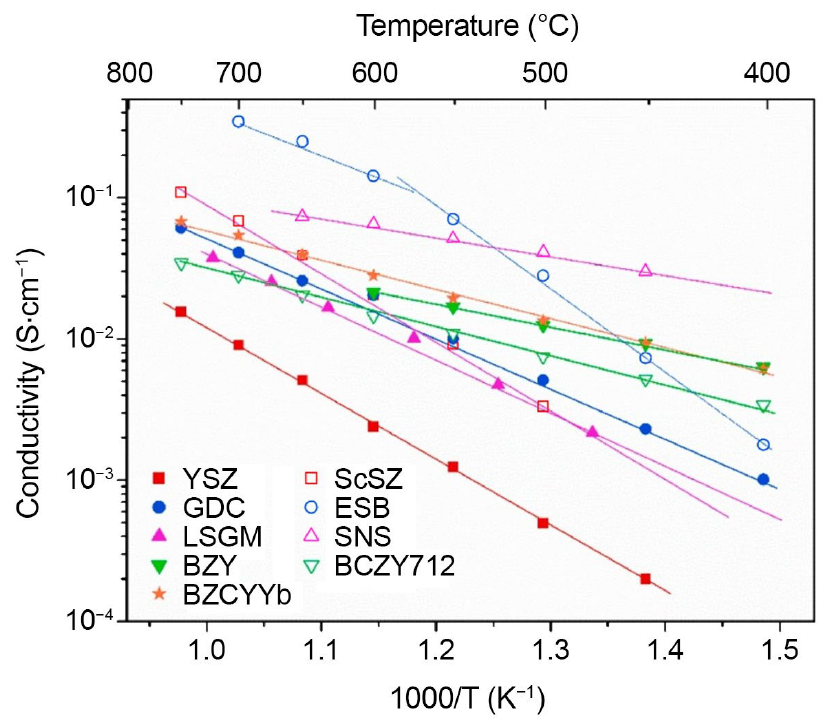
Figure 12. Conductivity of well-established solid-state electrolytes for SOFCs: 8 mol.% Y 2 O 3 –ZrO 2 (YSZ), 8 mol.% scandia-stabilized ZrO 2 (ScSZ), Gd 0.1 Ce 0.9 O 1.95 (GDC), Er 0.4 Bi 0.6 O 3 (ESB), La 0.8 Sr 0.2 Ga 0.8 Mg 0.2 O 3- δ (LSGM), Sr 0.55 Na 0.45 SiO 2.755 (SNS), BaZr 0.8 Y 0.2 O 3- δ (BZY), BaCe 0.7 Zr 0.1 Y 0.2 O 3- δ (BCZY712) and BaZr 0.1 Ce 0.7 Y 0.1 Yb 0.1 O 3- δ (BZCYYb) (adapted from